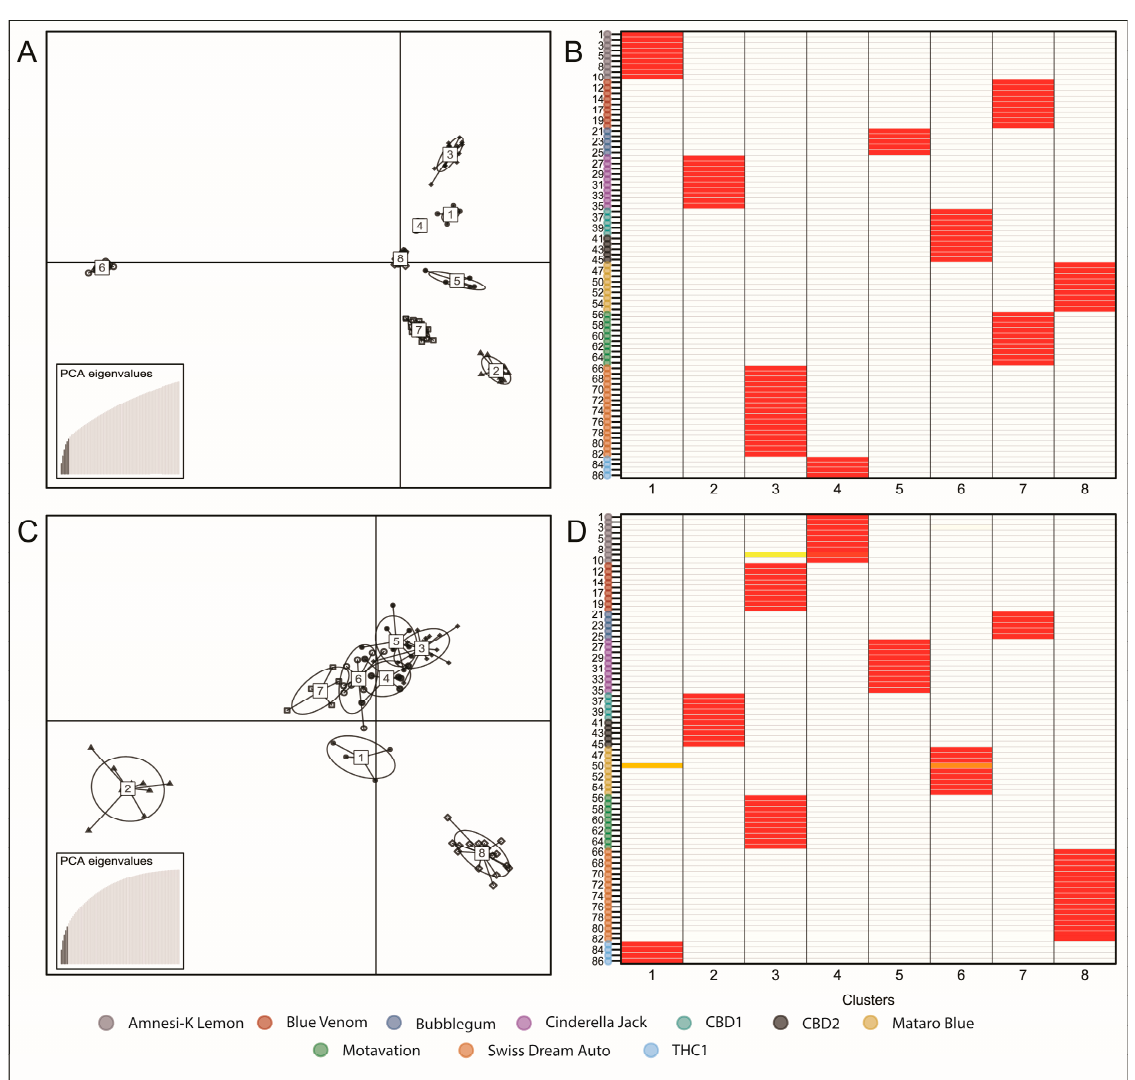
Figure 5. DAPC of two variant sets. ( A ) DAPC using the full set of 3608 SNPs produced 8 tight, and distinct clusters with each individual plant assigned to their respective cluster with high probability in an assignplot ( B ). ( C ) DAPC on a reduced set of diagnostic variants similarly resolved the assessed population into 8 distinct clusters, with all but 3 individual plants assigned to their cluster with high certainty in an assignplot ( D ).